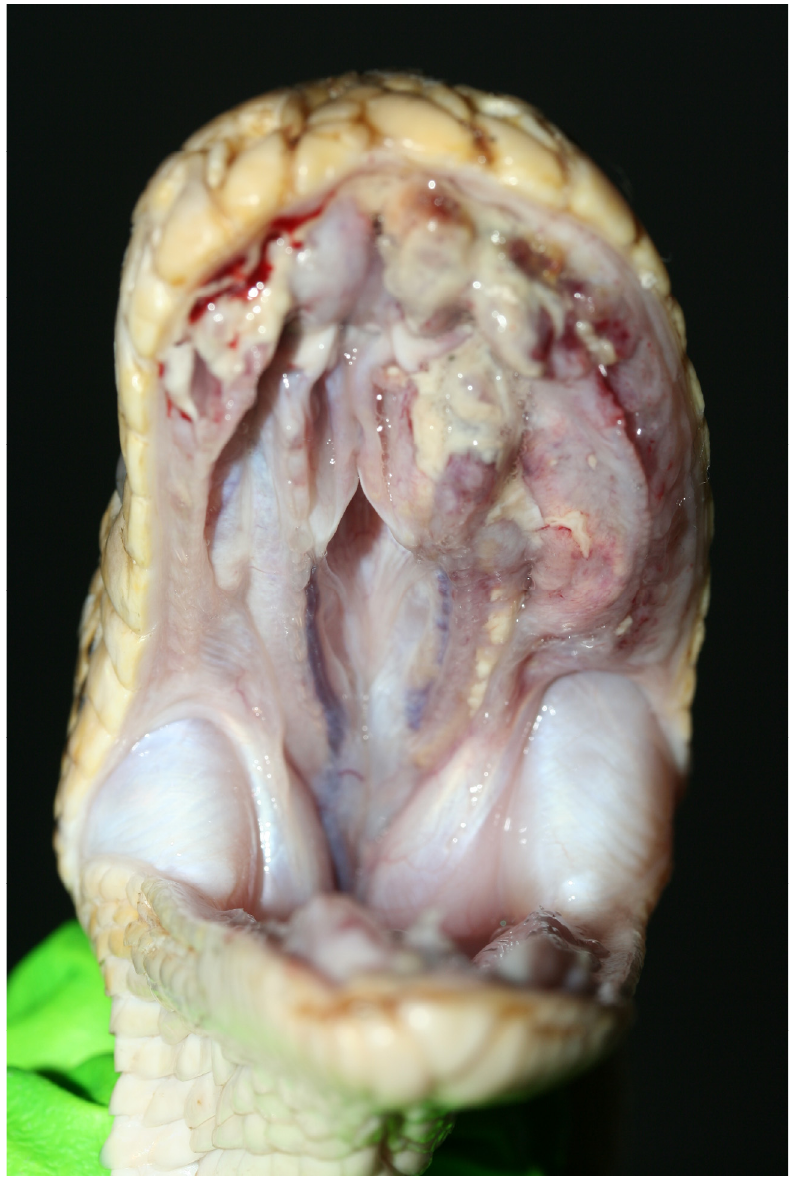
Figure 35. Caseous stomatitis as seen in this reticulated python ( Malayopython reticulatus ) is commonly seen in snakes with subspectacular infection as associated bacteria as well as flagellated protozoa may reach the subspectacular space following ascending infection via the lacrimal duct.